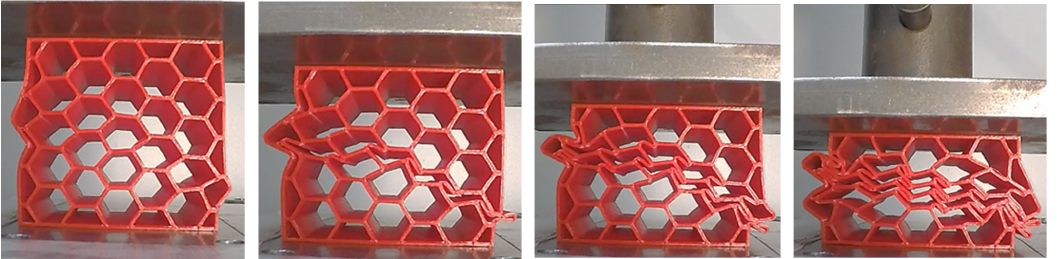
Table 4. Average values and standard deviations for the experimentally measured energy absorp ‐ tion, maximum reaction force at the initial elastic peak, and energy absorption per unit mass, for the novel and hexagonal geometries under lateral loads and for both dimensional scales. Honeycomb Geometry